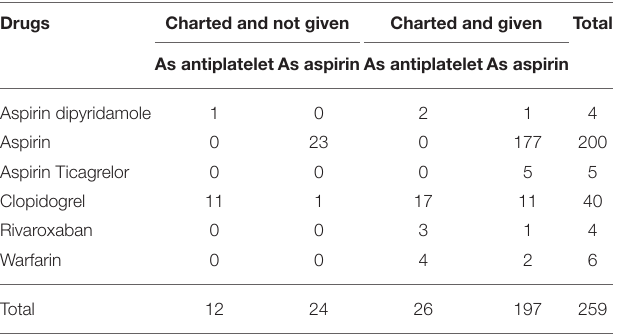
TABLE 1 | Charting of antithrombotics for immediate and one-off “stat” administration. Drugs Charted and not given Charted and given